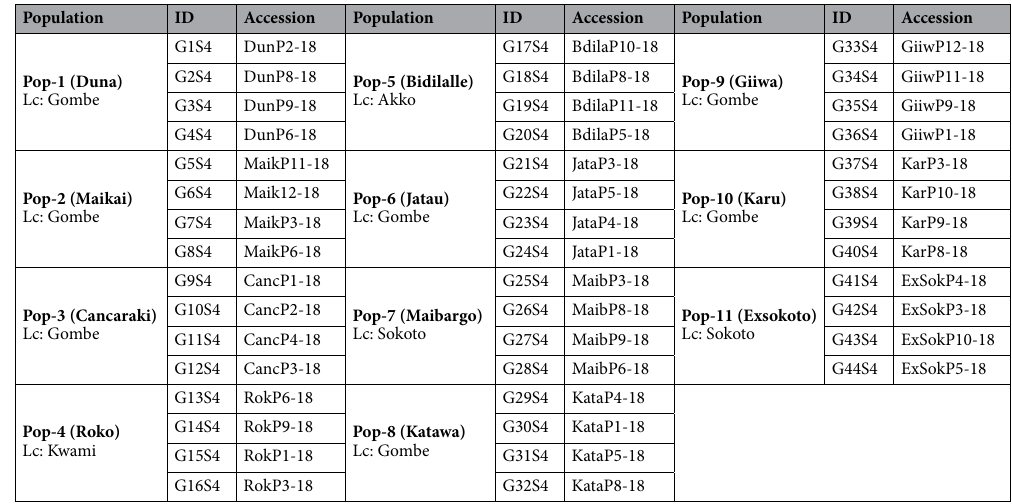
Table 1. List of Bambara groundnut accessions, population name, code, and their major growing area. Pop population, Lc location or area, G genotype, S selfed generation, Dun Duna, Maik Maikai, Canc Cancaraki, Rok Roko, Bdila Bidilalli, Jata Jatau, Maib Maibargo, Kata Katawa, Giiw Giiwa, Kar Karu, Exsok